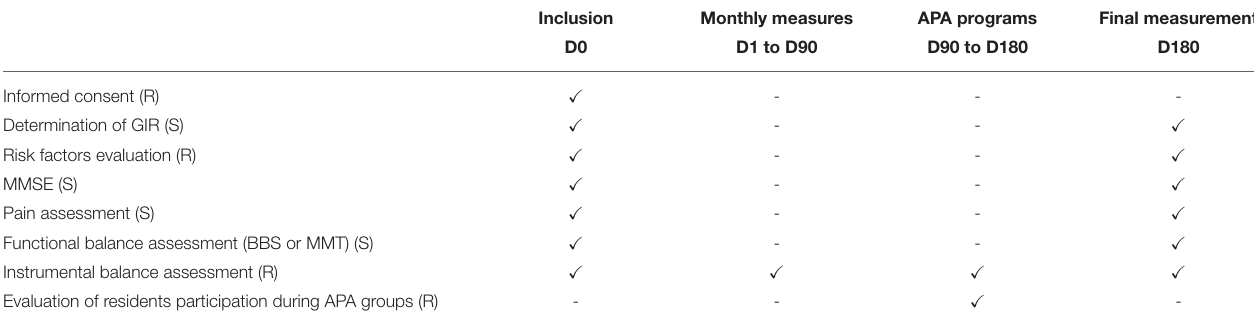
TABLE 1 | Measurements time